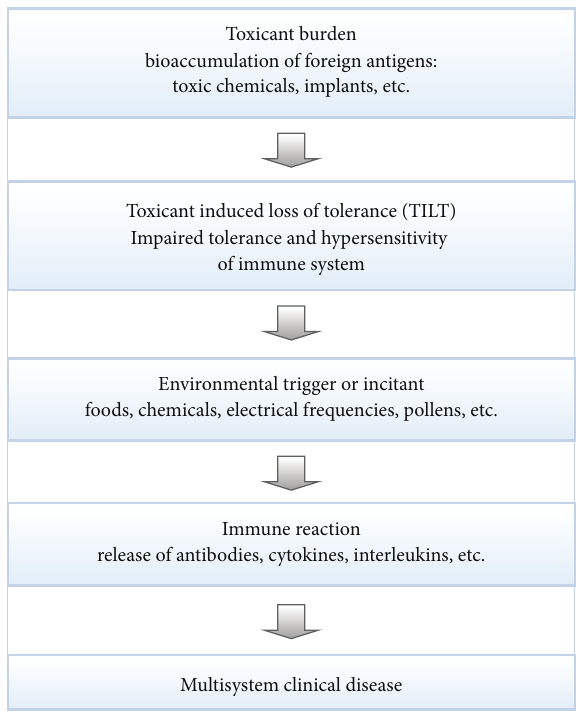
Figure 2: Sensitivity related illness: a causative pathway to multi-